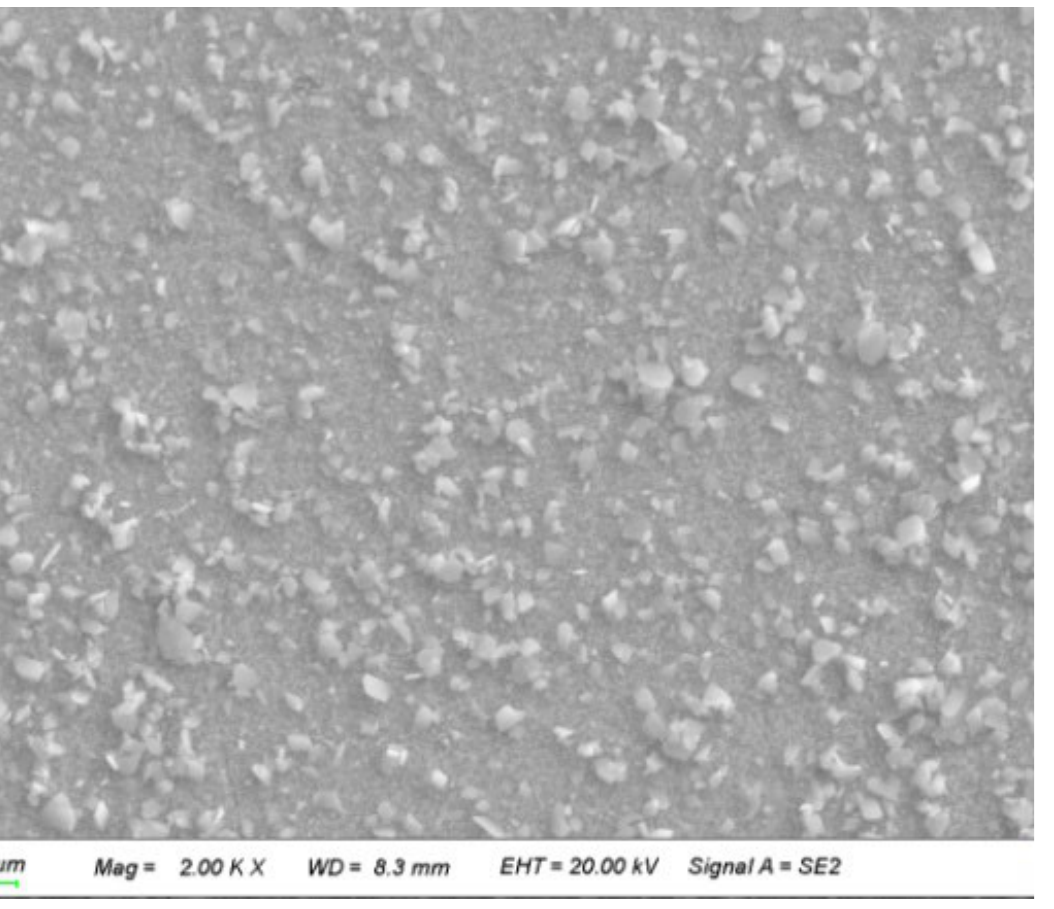
Figure 9. Microstructure after corrosion in 360 °C high temperature and high pressure water environment for 14 days of FeCrMnNi alloy.